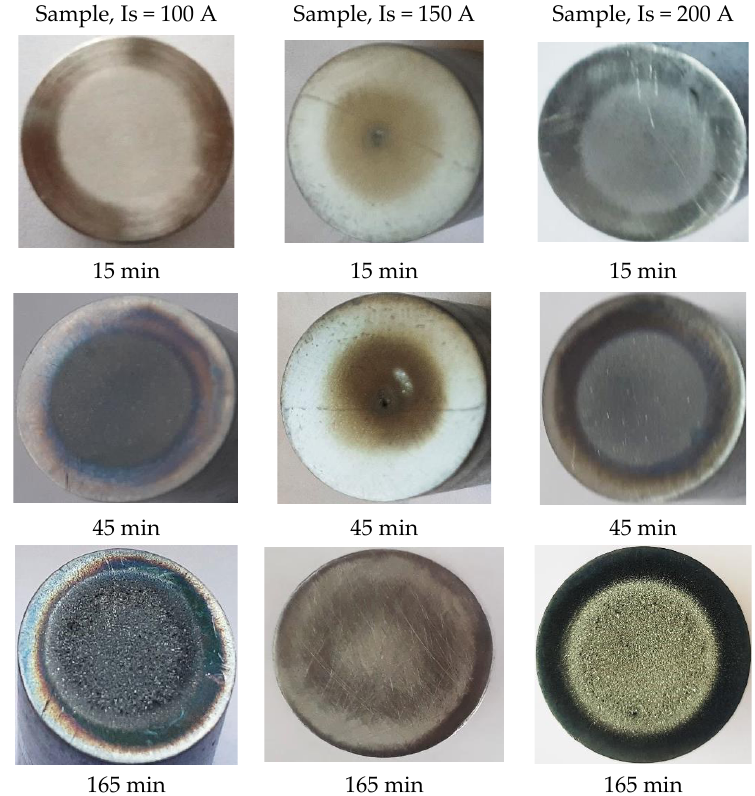
Figure 8. The macrographic image of the TIG surface remelted sample, with different current intensities, after the cavitation attack.